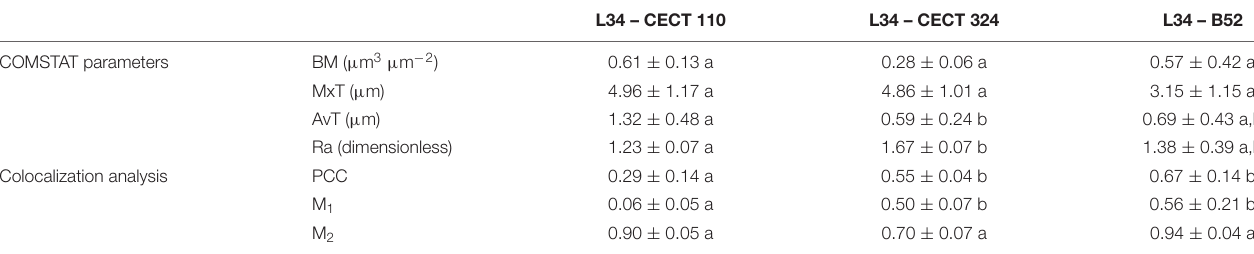
TABLE 2 | Confocal laser scanning microscopy parameters of 48 h L. monocytogenes – Pseudomonas spp. mixed-species biofilms obtained after image analysis with COMSTAT 2.1. and colocalization analysis with JACoP (v2.0) plugin in ImageJ (see section “Epifluorescence Microscopy Assays” for further detail).